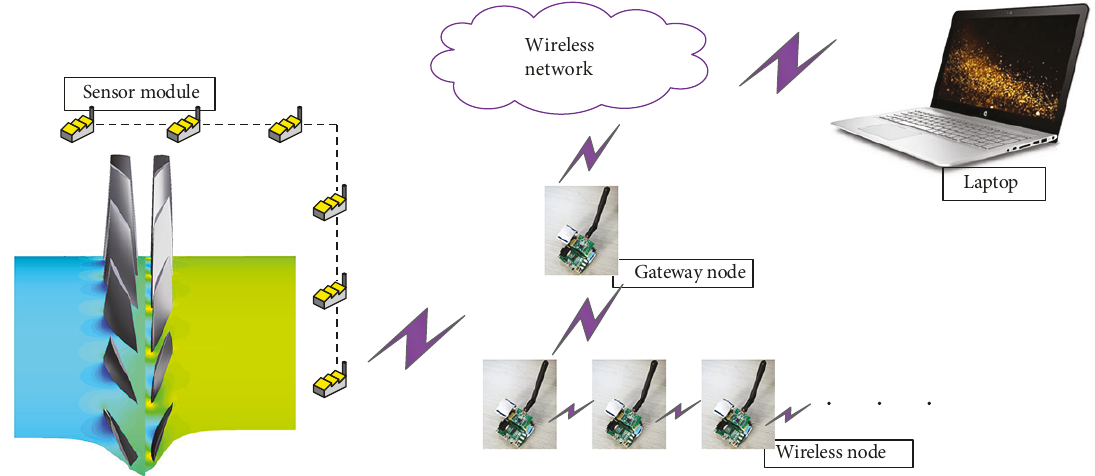
Figure 2: Applicable ZigBee nodes for contrarotating axial